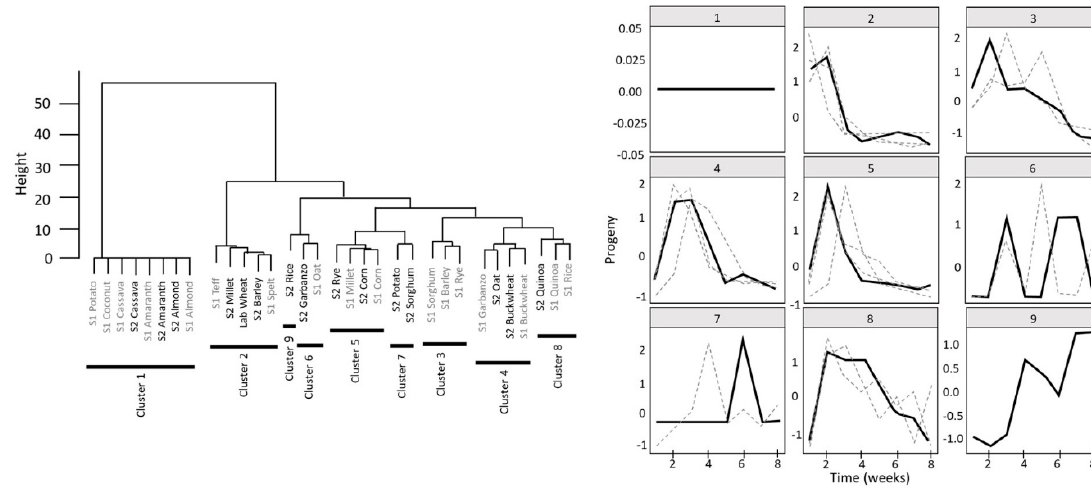
Figure 2. Dendrogram and clustered curves for progeny emergence over time for flour and source. Source 1 (S1) is represented by gray text in the dendrogram and Source 2 (S2) is black text. Black curves in the clusters represent the centroid of the curve fitting. Dashed curves represent any other output curves that did not fit directly on the centroid curve but have good fit in the cluster.